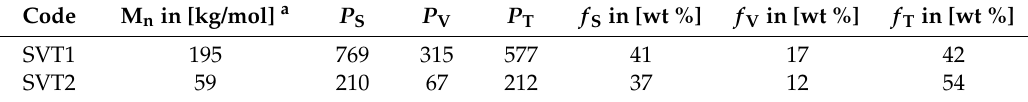
Table 1. Polymer specifics of the employed SVT triblock